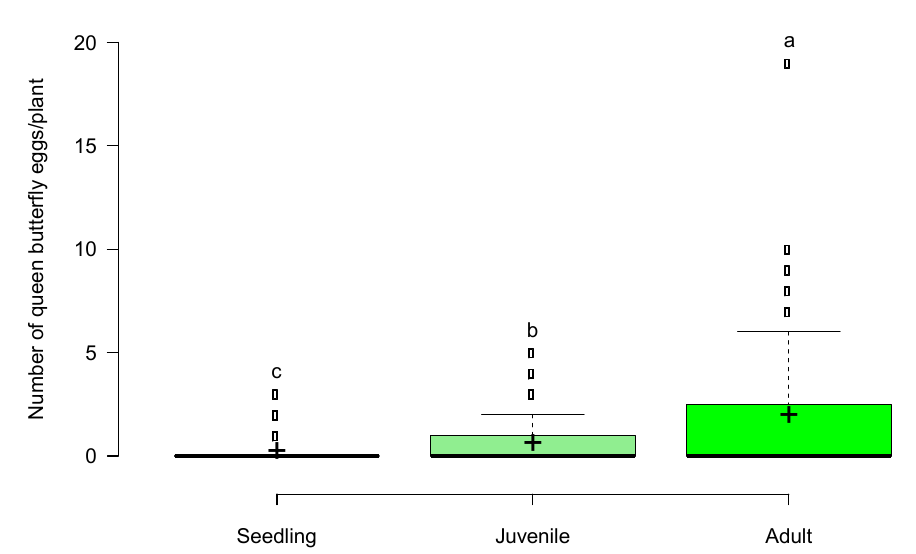
Figure 5. Box plot of queen butterfly oviposition on seedling, juvenile, and adult Mojave milkweed host plants documented during the spring season, 27 April–1 June 2017, Ivanpah Valley, Mojave Desert, California, USA. Di ff erent letters indicate significantly di ff erent pairwise caparisons of mean egg counts (plus signs) between life stages. We set α = 0.05.